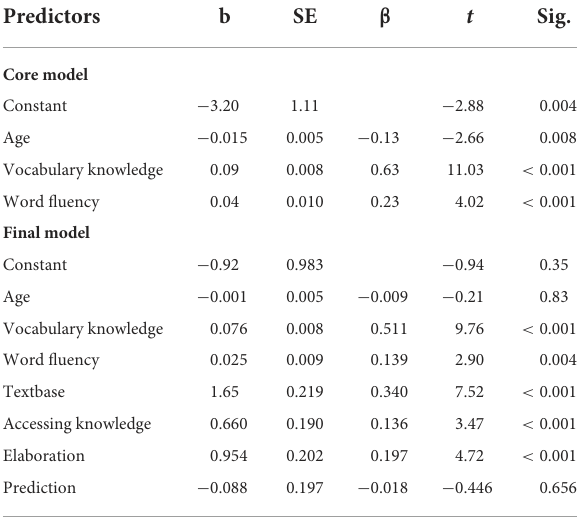
TABLE 5 Reading comprehension regression models for the full